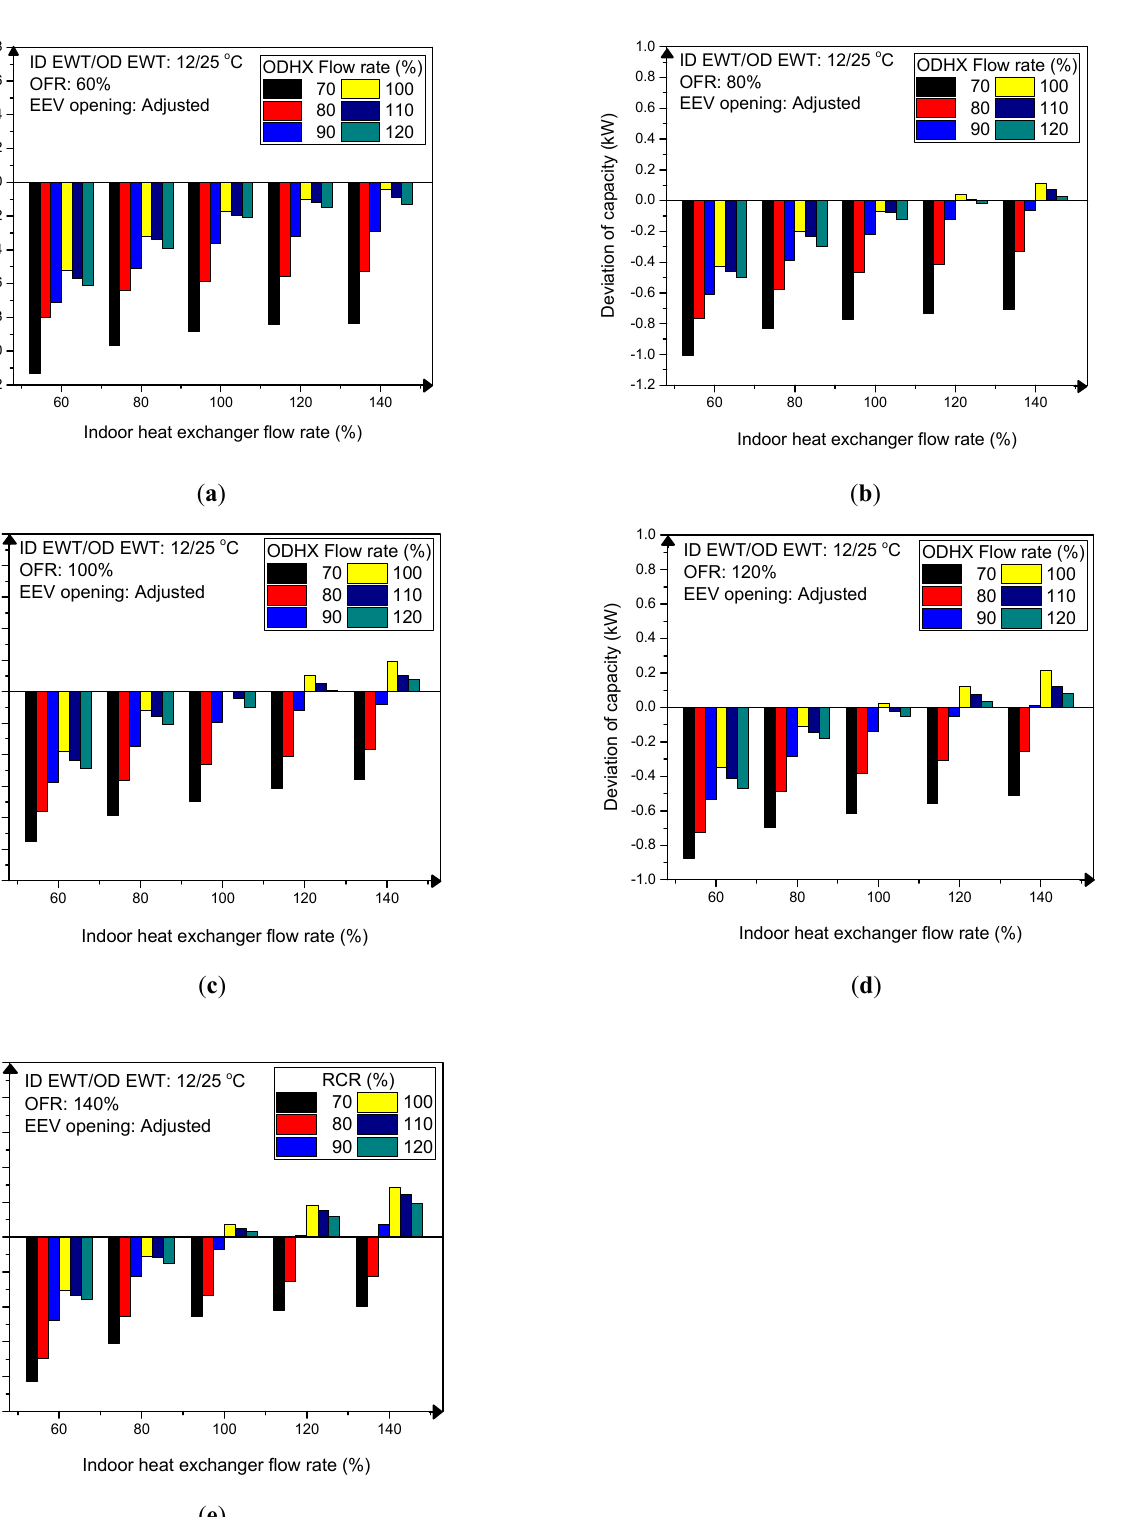
heat exchanger of ( a ) 60%, ( b ) 80%, ( c ) 100%, ( d ) 120% and ( e )